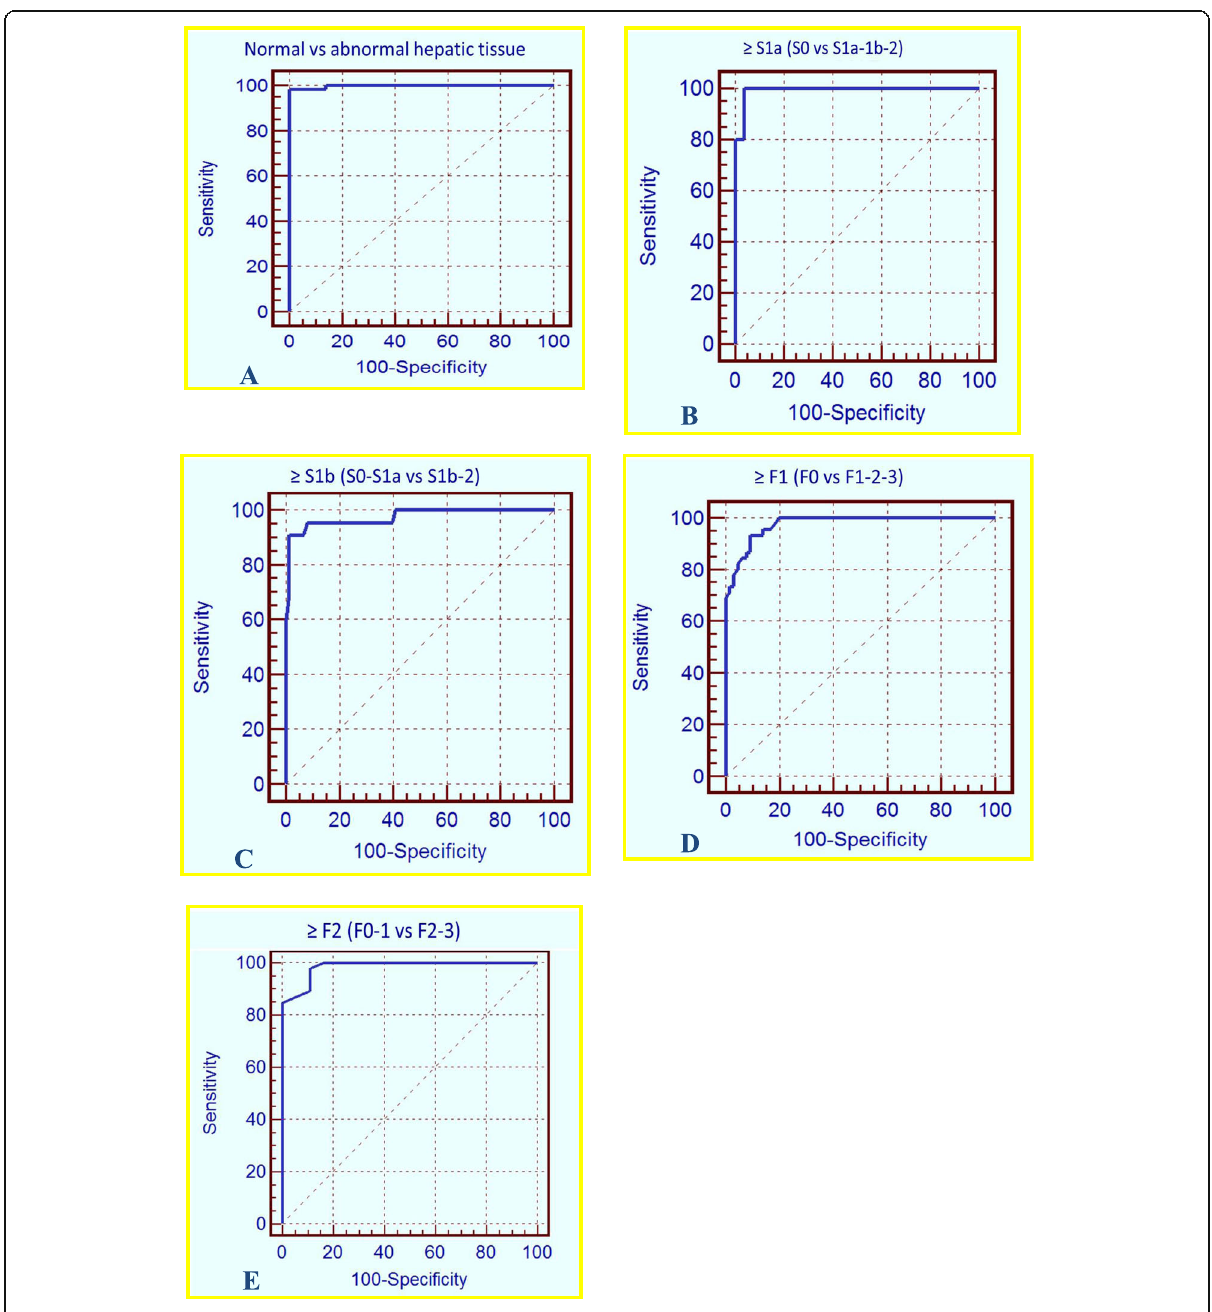
Fig. 7 a – e Demonstrates the ROC curve analysis of the diagnostic reliability of MRE technique in the pre-transplant evaluation of the studied LLDs candidates. The MRE was accurately discriminated between absolutely normal and abnormal hepatic tissues by using an optimal cut-off value of liver stiffness value ≥ 2.24 kPa with 0.992 AUC, 98.65% sensitivity, 100% specificity, and 99.24% accuracy ( a ). Moreover, MRE technique was accurately detected hepatic steatosis of grade ≥ S1a by utilizing a cut-off value of liver stiffness ≥ 2.35 kPa with 0.981 AUC, 96.83% sensitivity, 100% specificity, and 98.10% accuracy, while it detected hepatic steatosis of grade ≥ S1b at a cut-off value of liver stiffness ≥ 2.38 kPa with 0.984 AUC, 96.90% sensitivity, 100% specificity, and 98.44% accuracy ( b and c , respectively). Additionally, MRE technique identified fibrosis of grade ≥ F1 by using an optimal cut-off value of liver stiffness ≥ 2.42 kPa with 0.990 AUC, 97.51% sensitivity, 100% specificity, and 99% accuracy, while it detected hepatic fibrosis of grade ≥ F2 by using an optimal cut-off value of liver stiffness ≥ 2.57 kPa with 0.988 AUC, 97.22% sensitivity, 100% specificity, and 98.80% accuracy ( d and e ,